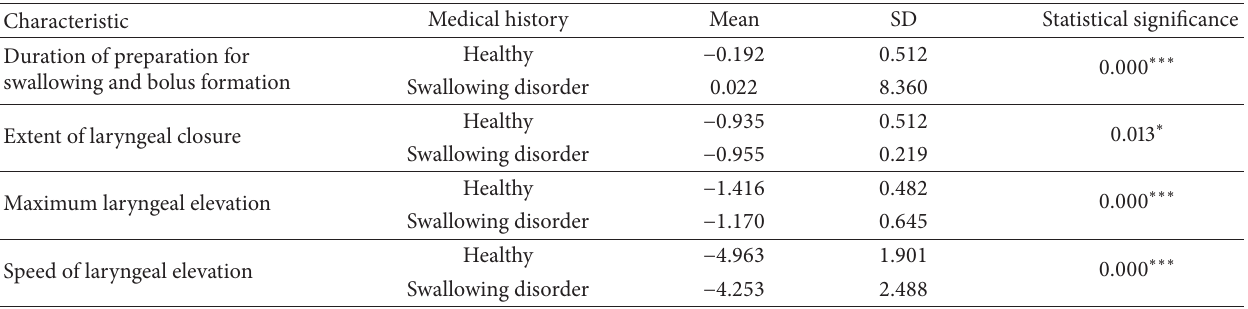
Table 3: Group swallow parameters.